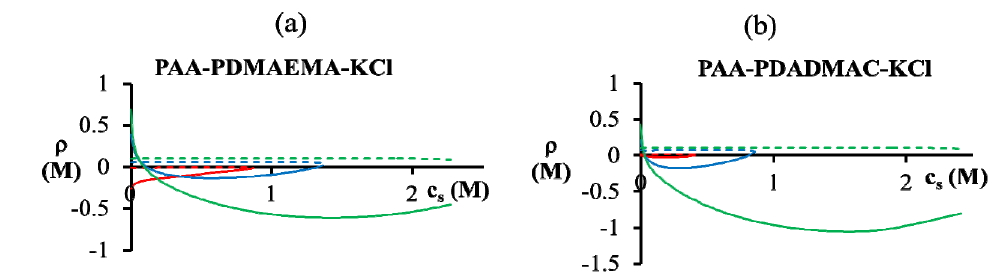
Figure 8. Net charge due to PDMAEMA or PDADMAC and PAA in the dense phase (bold lines) and supernatant (dashed lines) for ( a ) PAA ( b ) PAA -PDADMAC -KCl. pH values are pH = 4 (green), pH = 5 (blue), and 597 557 (PAA) = 0.75 is used for both the pH = 7 (red). (cid:2031) (cid:2879)(cid:3050)